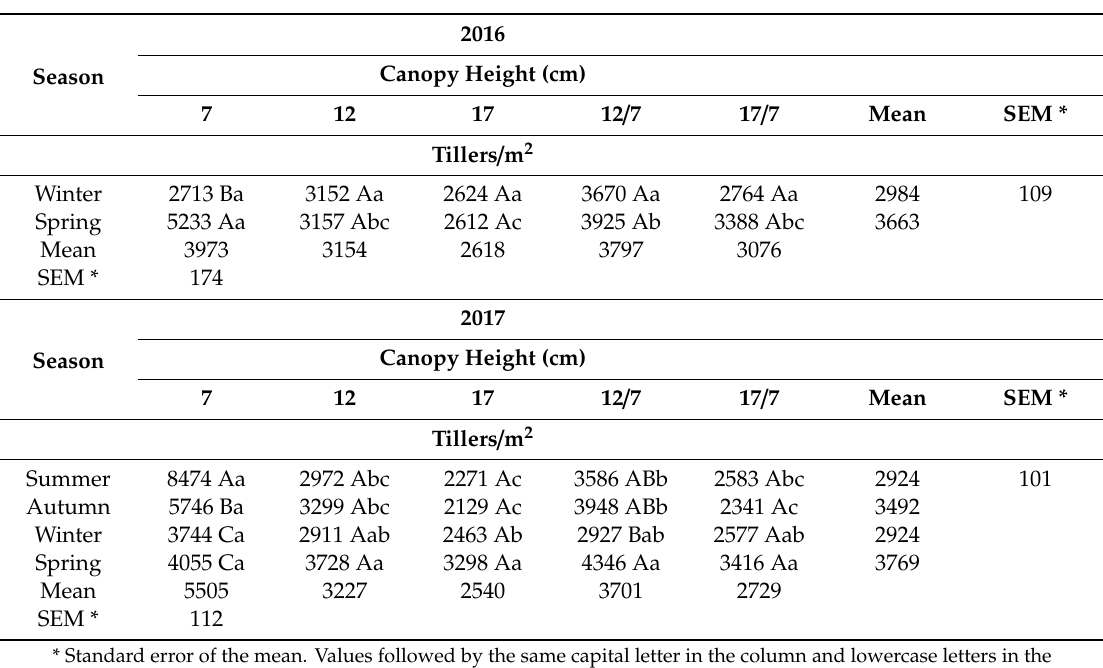
Table 4. Tiller population density (tillers / m 2 ) in mixed canopies of kikuyu-grass and tall fescue submitted to grazing in di ff erent